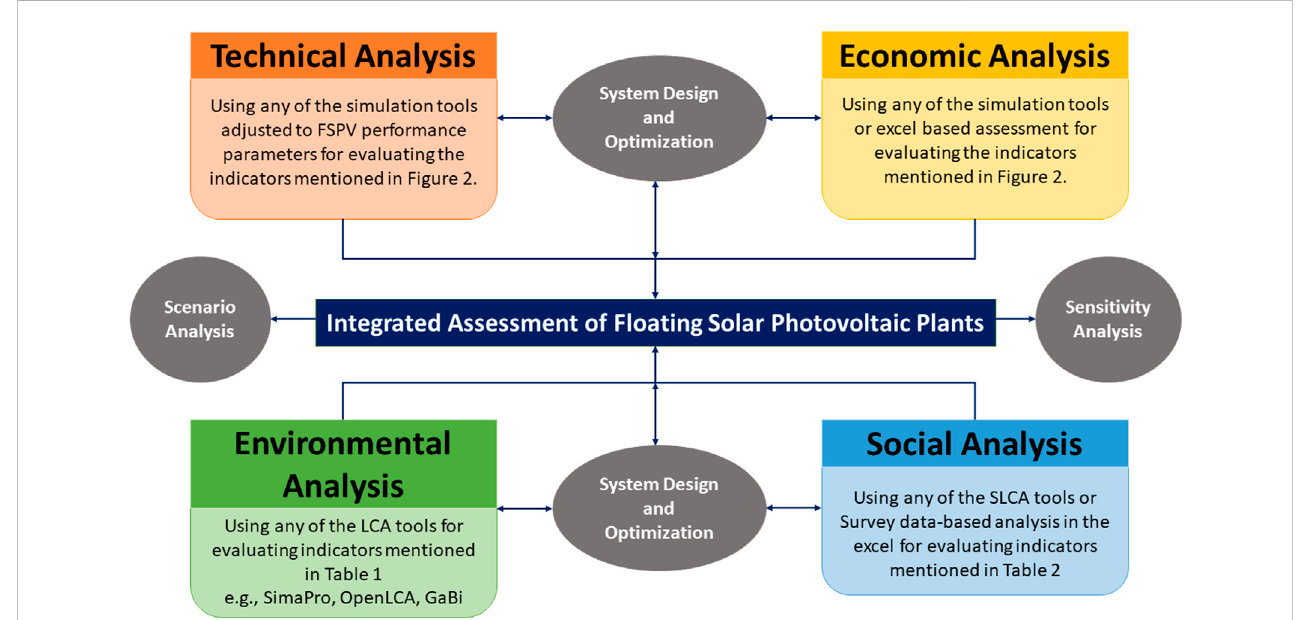
FIGURE 7 Integrated assessment of fl oating solar photovoltaic plants as per techno-economic-environmental and social